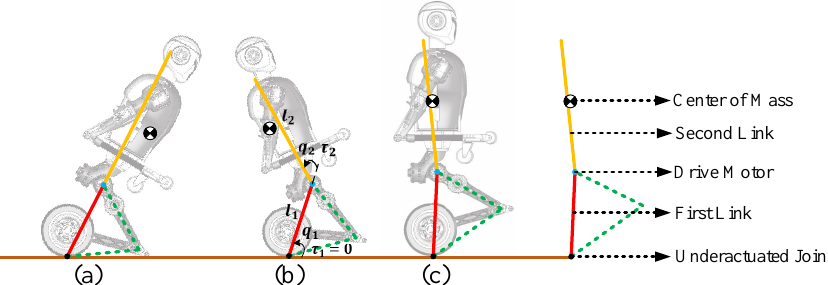
Figure 9. An under-actuated second-order inverted pendulum model: ( a ) The kneeling posture; ( b ) The leaning back posture; ( c ) The squatting